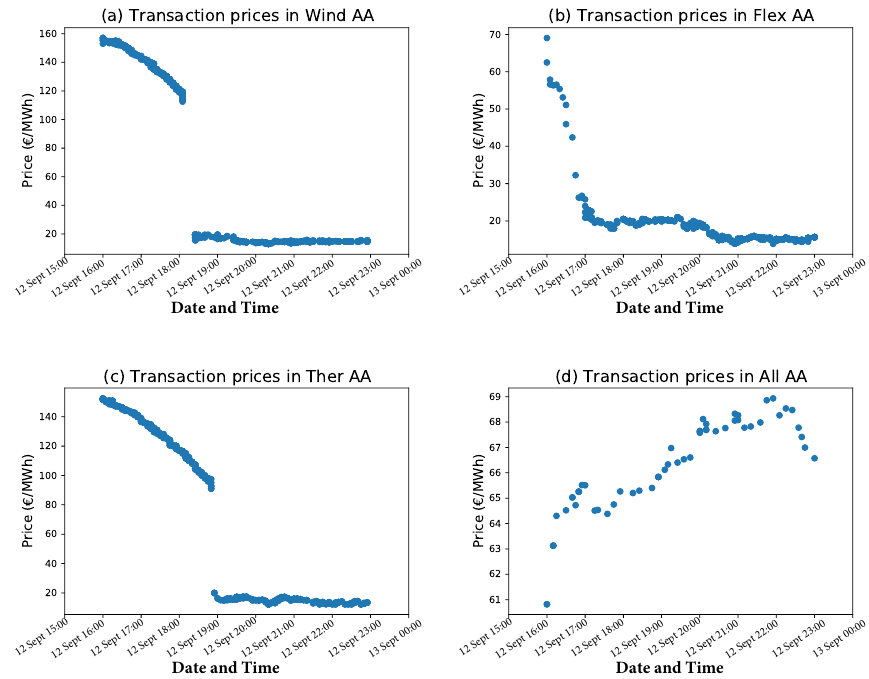
Figure 5. Effect of different price–volume strategies on transaction prices with respect to trading time in ( a ) Wind AA ; ( b ) Consumer AA ; ( c ) Thermal AA ; and ( d ) All AA